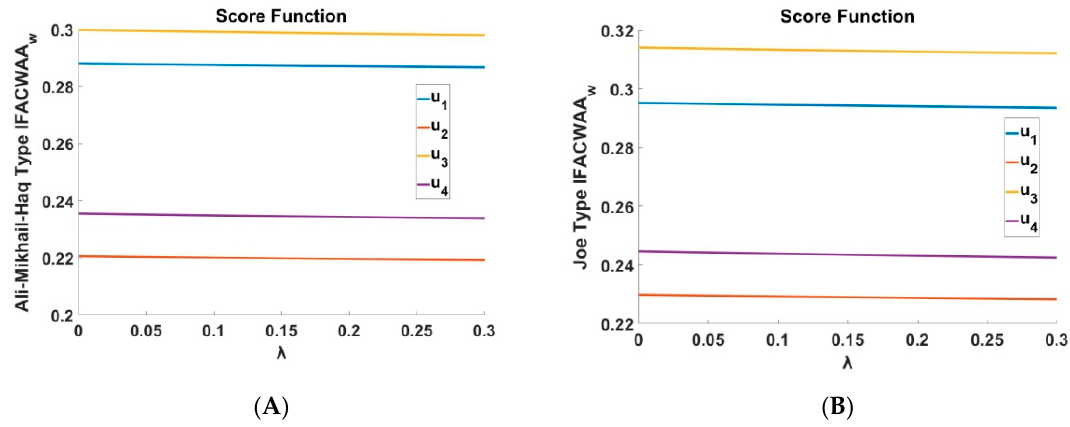
Figure 2. ( A ) Figure 2. ( A ) Ali-Mikhail-Haq-type